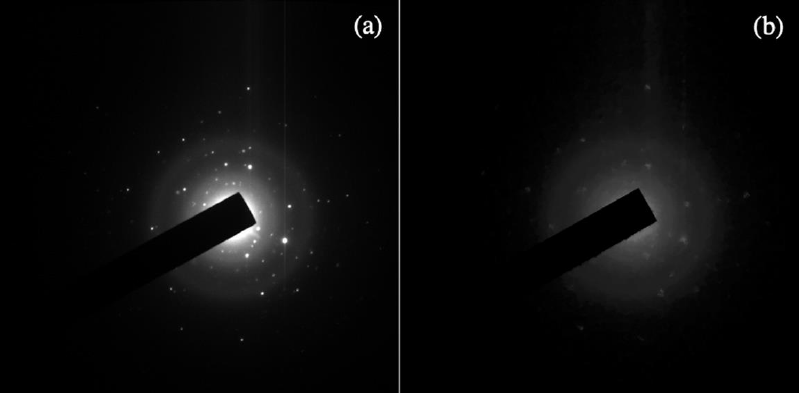
Figure 1. Selected area electron di ff raction patterns of a specimen consisting of nanoparticles of Vincamine; ( a ) after an exposure to the electron beam with a density of current of 300 e − Å − 2 s − 1 for 0.01 sec [4] and ( b ) after an exposure to the same current density for 0.3